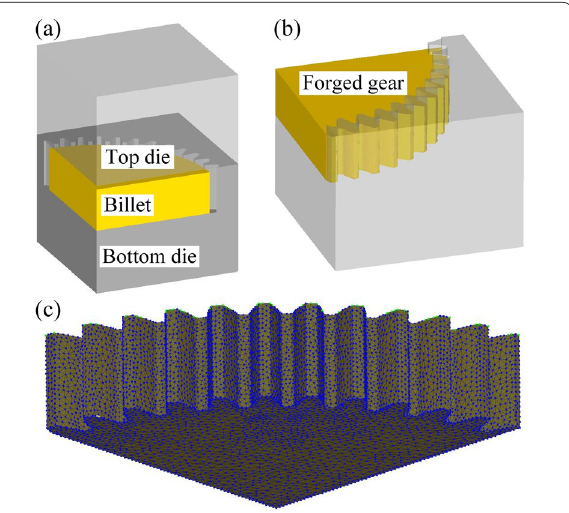
Figure 10 The closed-die forging simulation: (a) the FEM model before forging, (b) the forged gear with bottom die and c details of the forged